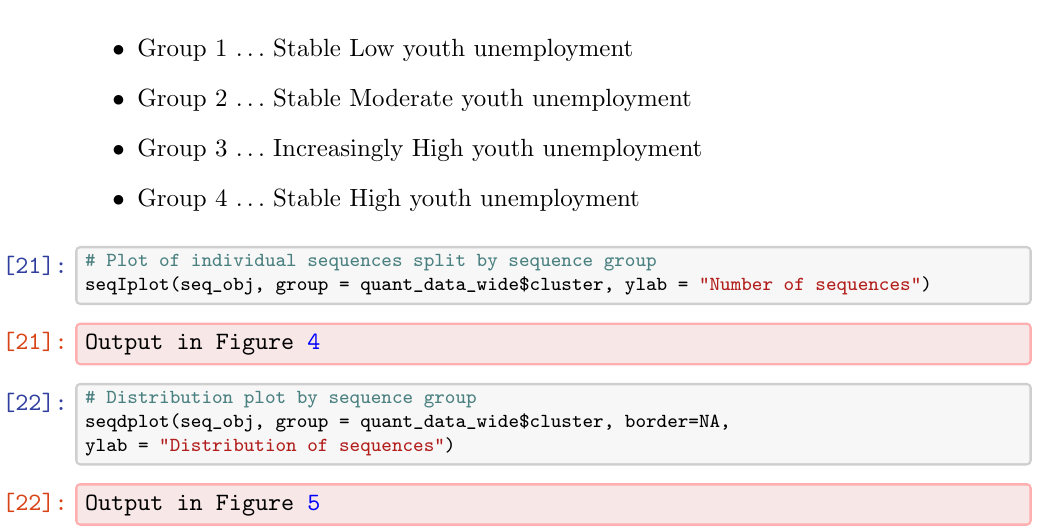
Figure 4: Individual sequences by sequence